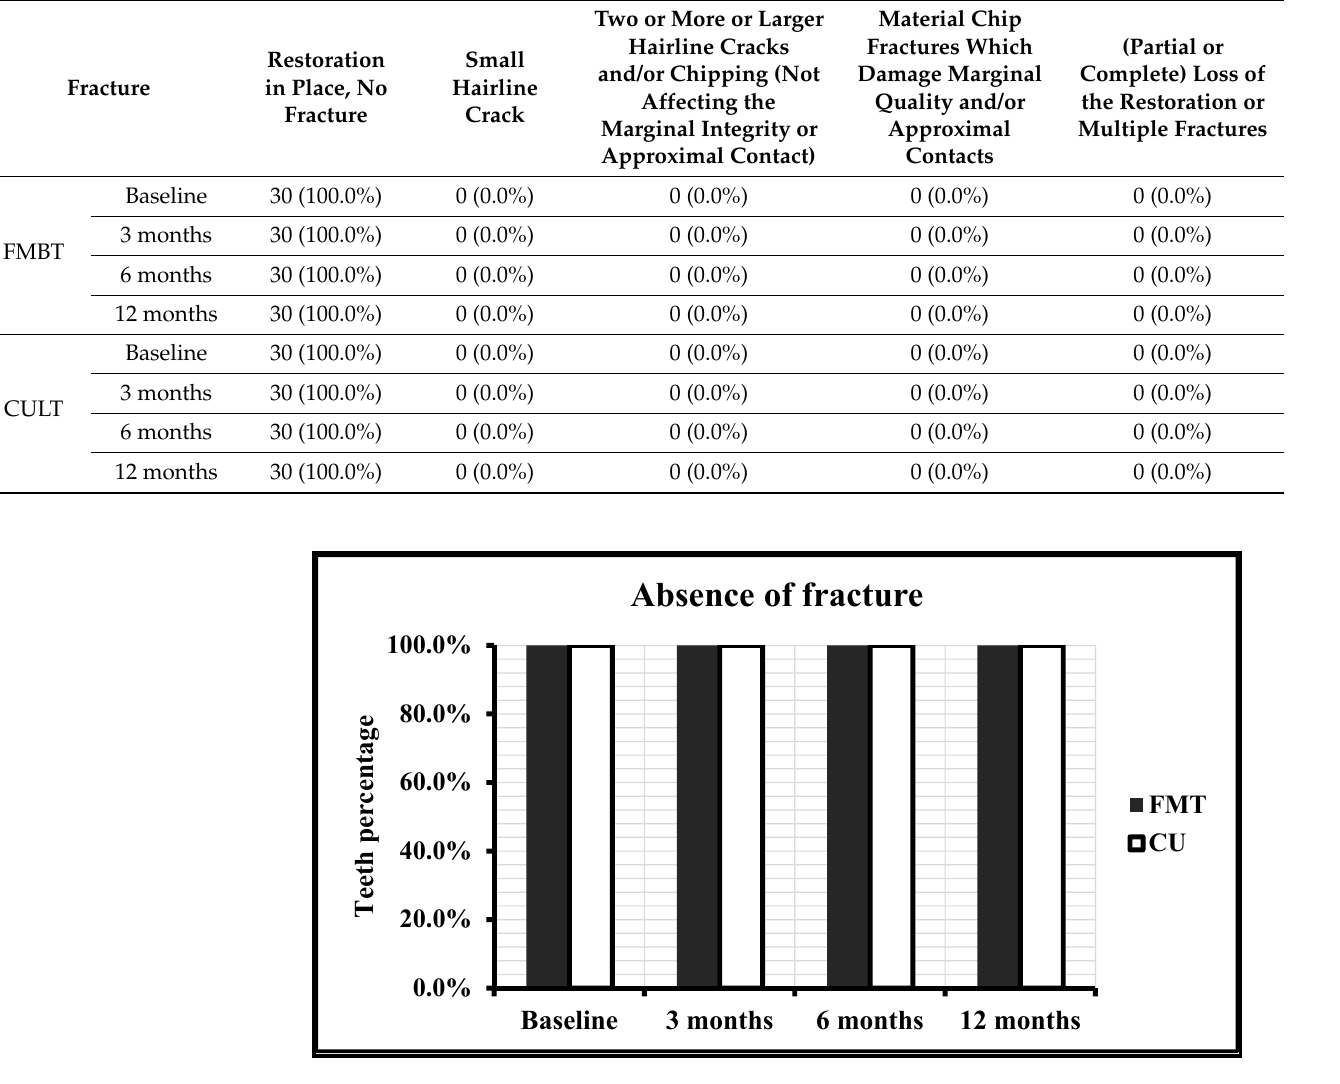
Table 6. Assessment of marginal integrity of restored teeth with FMBT and CULT over time ( p > 0.05).